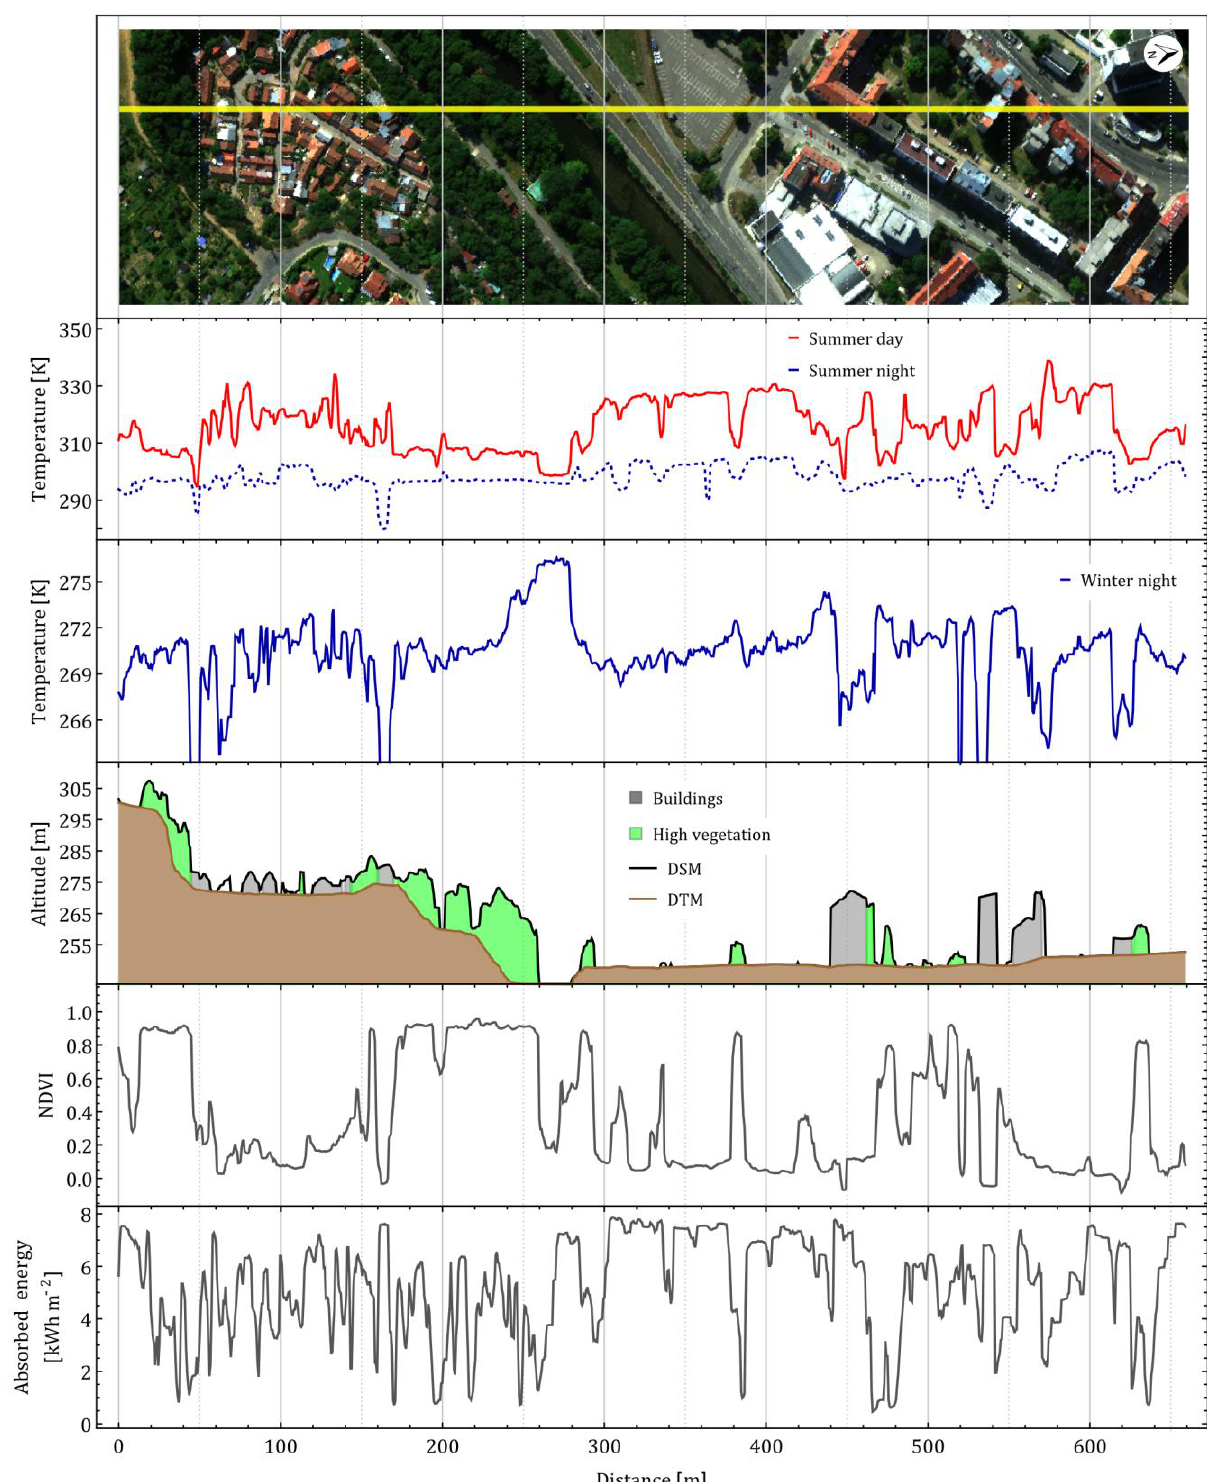
Figure 2. Visualisation of transect 2. For a detailed explanation, please, see the section